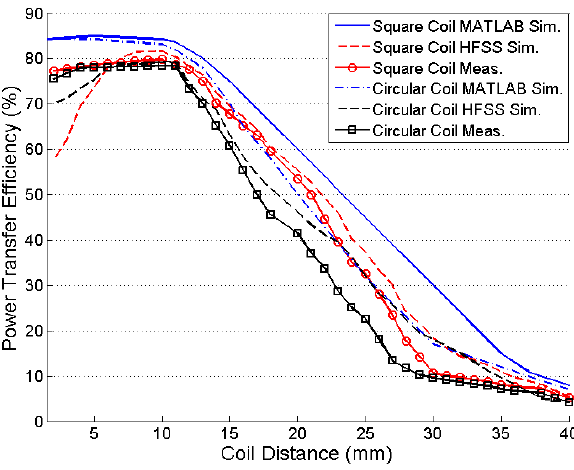
Figure 15. Efficiency versus coupling distance.